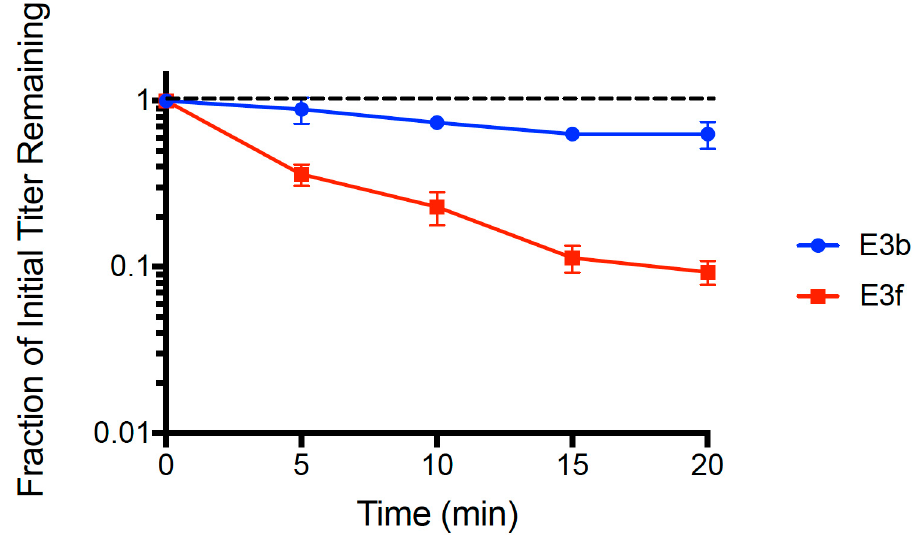
Figure 3. Adsorption of clones E3b and E3f on dead E. coli O157:H7 cells (MOI = 0.01). E3b has the wildtype gene gp38 whereas E3f has fixed Y159H, Q161H and T207I mutations in gp38 . Both clones contain an identical large deletion in gene gp37 . The error bars represent 1 standard deviation.